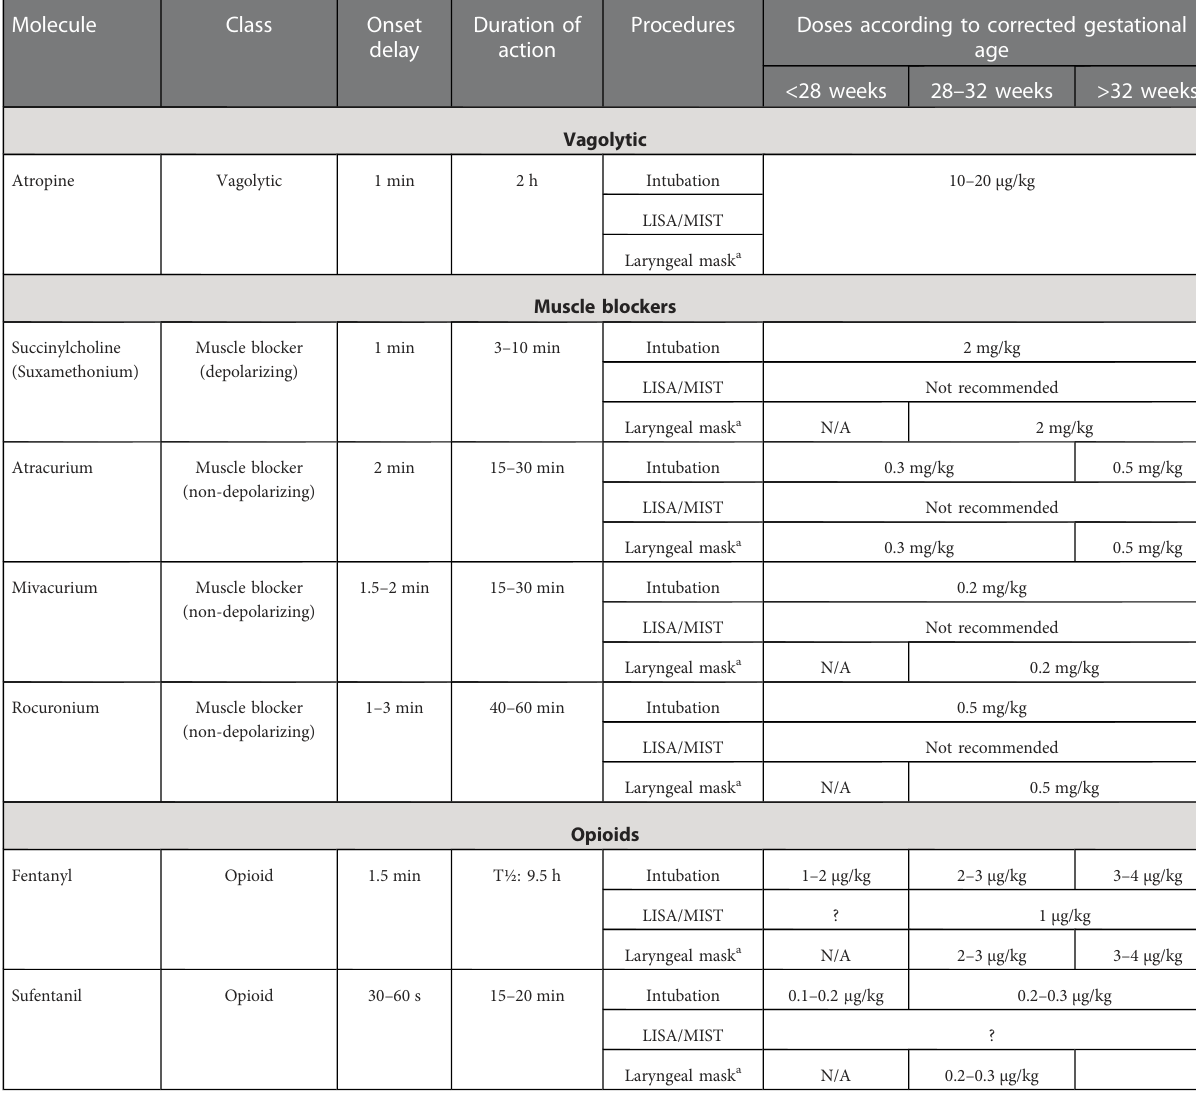
TABLE 3 Proposed doses for possible vagolytics, muscle blockers and opioids for premedication before laryngoscopy.